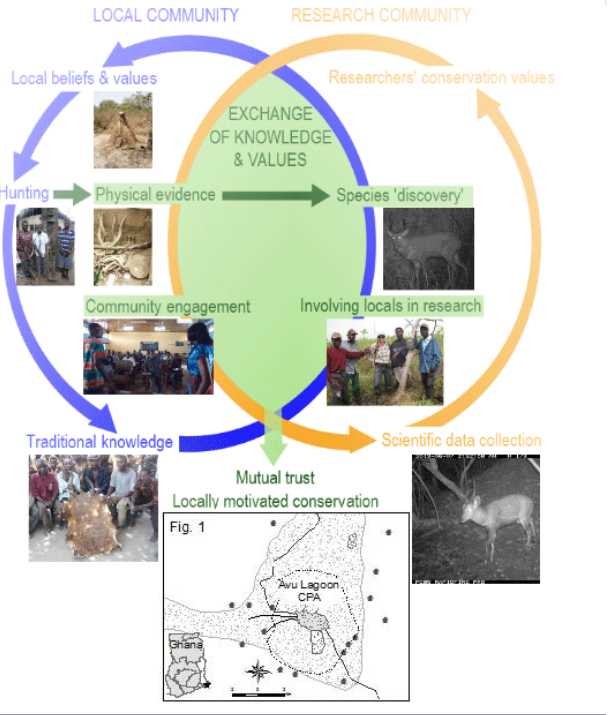
Fig. 5 . Illustration of the conservation benefits generated